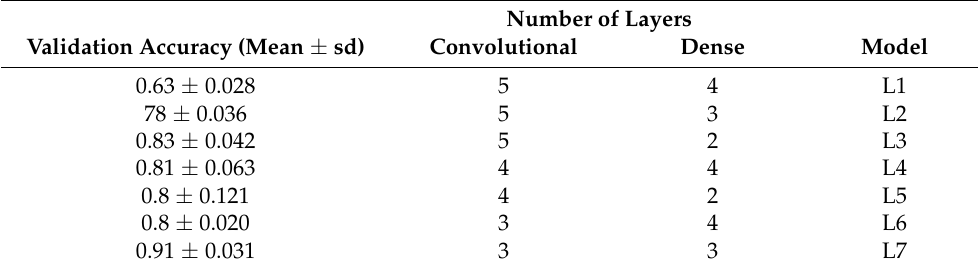
Table A1. Different architectures tested to ascertain the ideal number of layers in the CNN model ( n = 28).